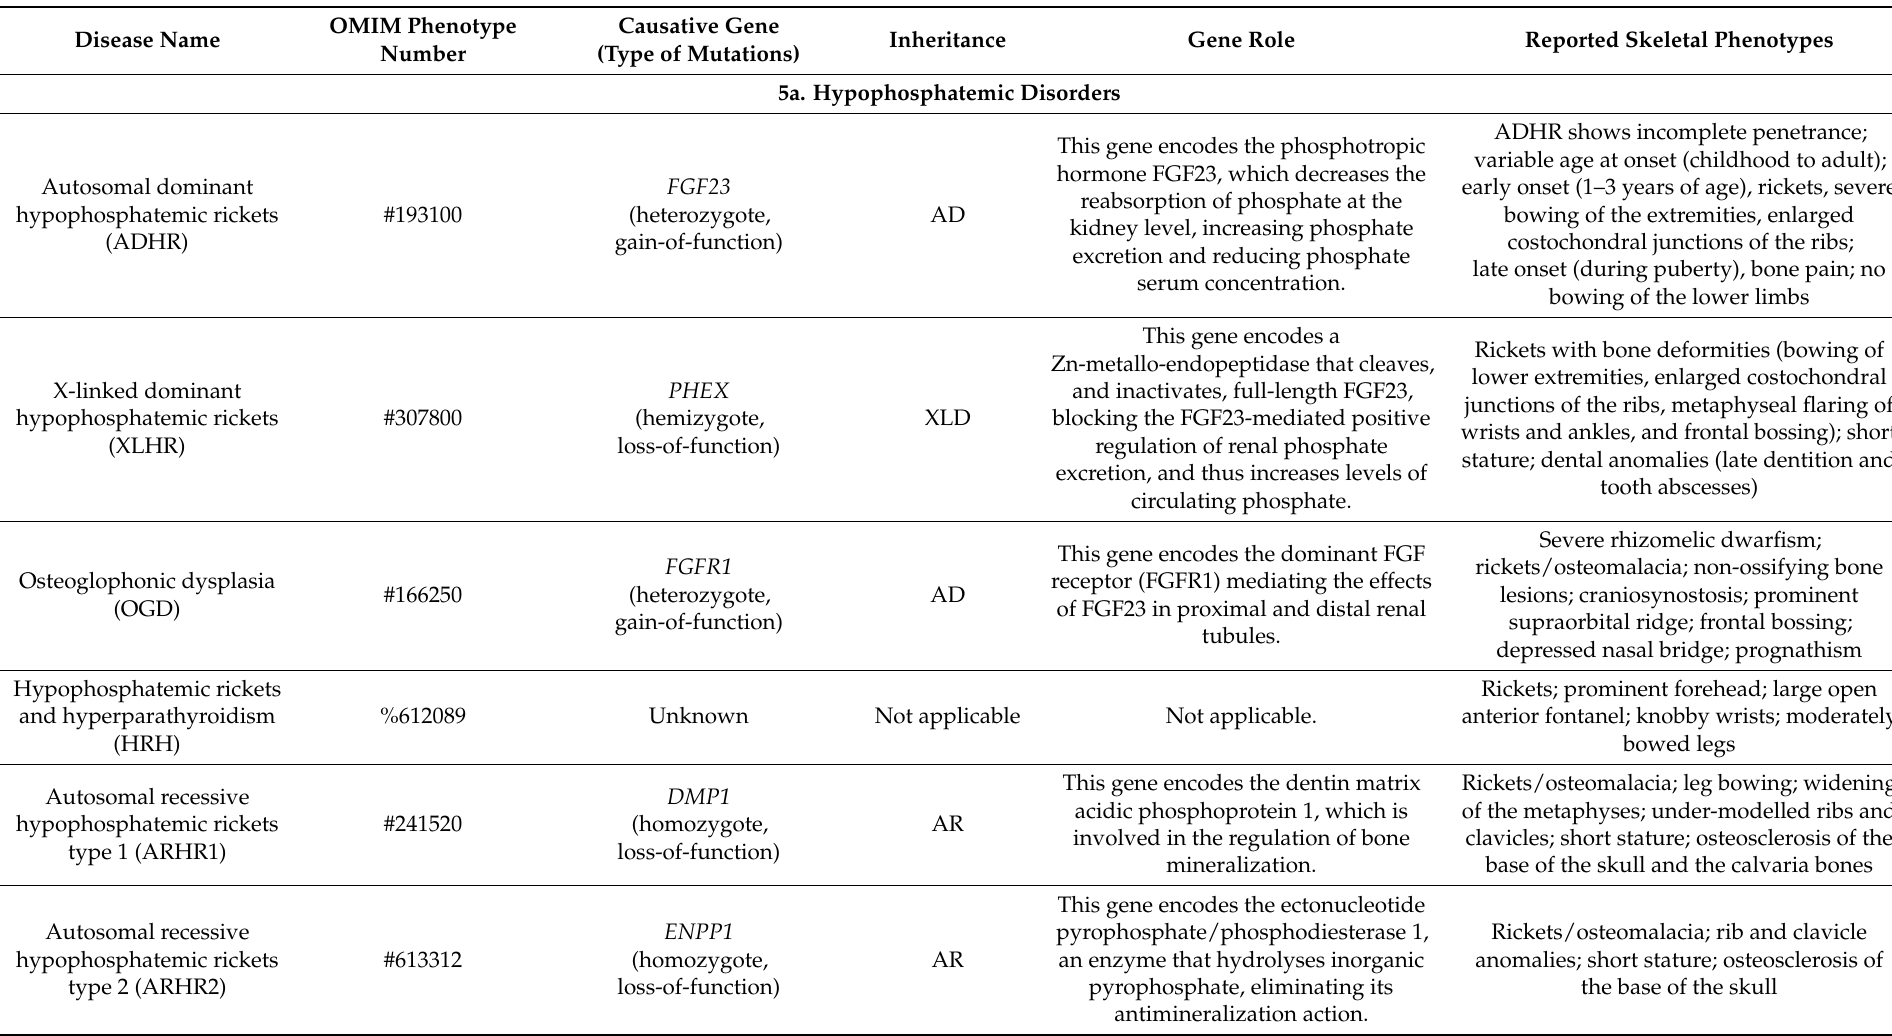
Table 5. Congenital disorders of the phosphate